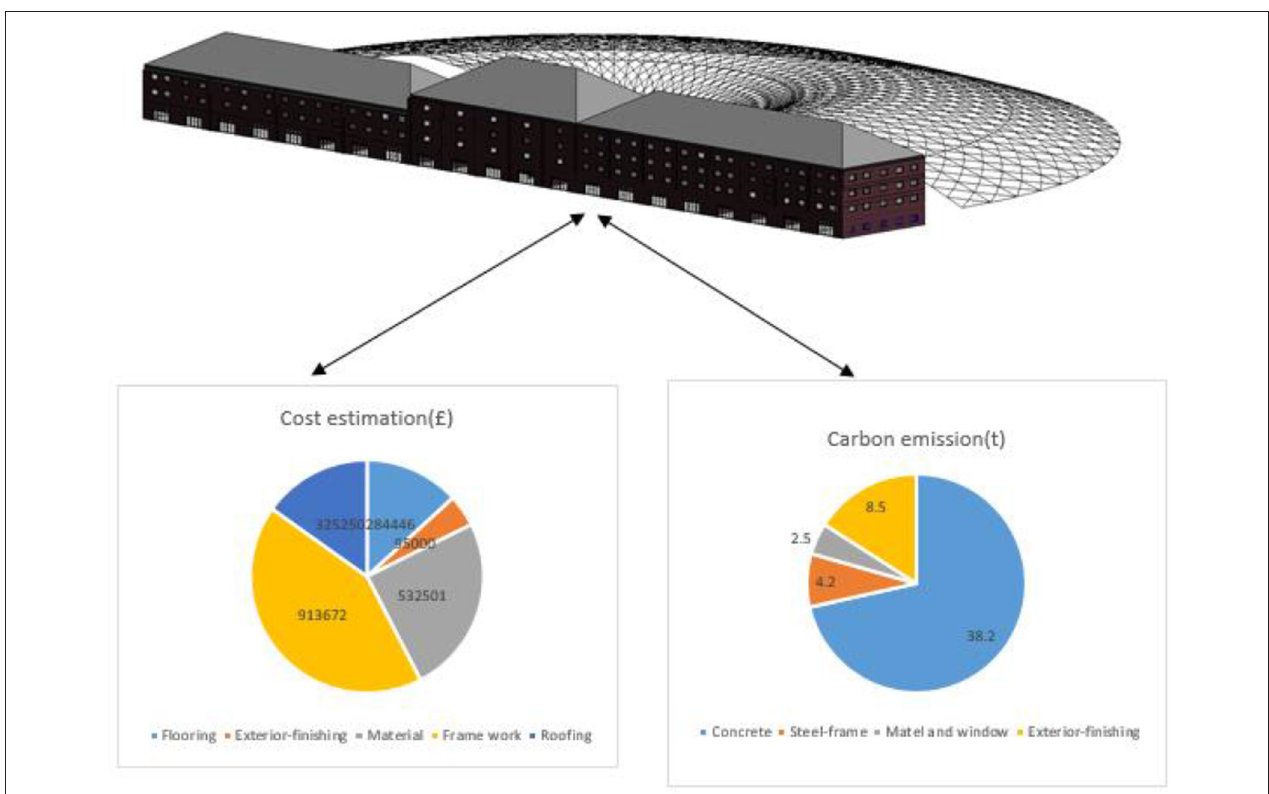
FIGURE 4 | Project cost estimation and carbon emission